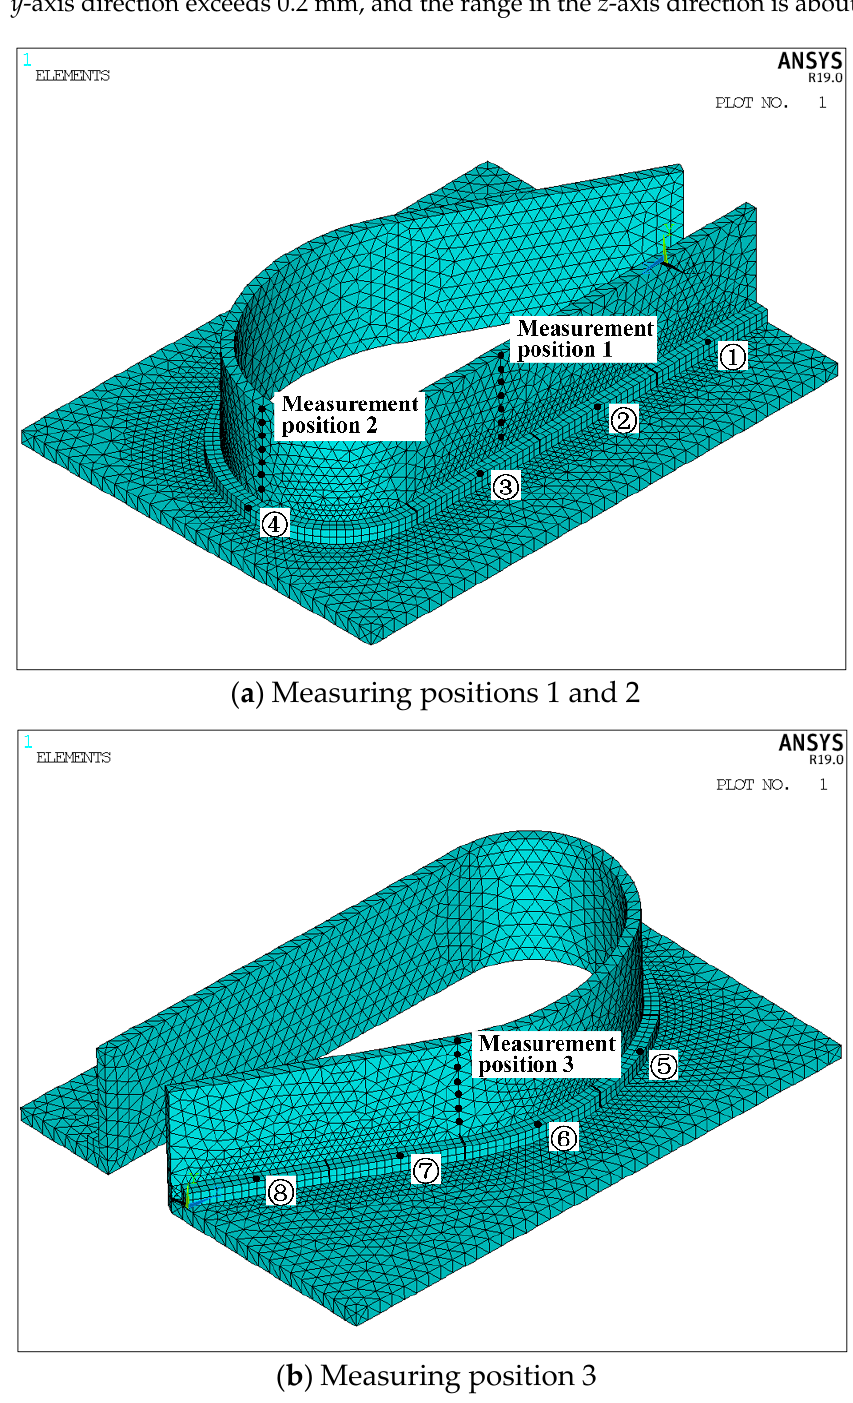
Figure 13. Welding deformation cloud map of welded structure 4 along the x -axis and z -axis under the optimal welding sequence.